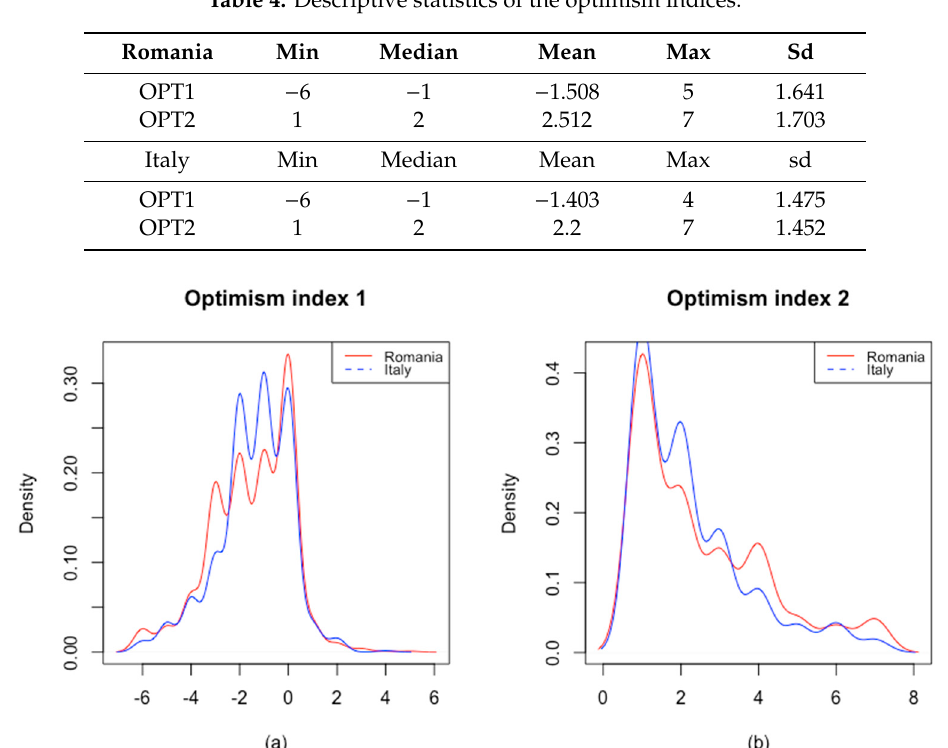
Table 3. Items involved in the optimism bias measurement.